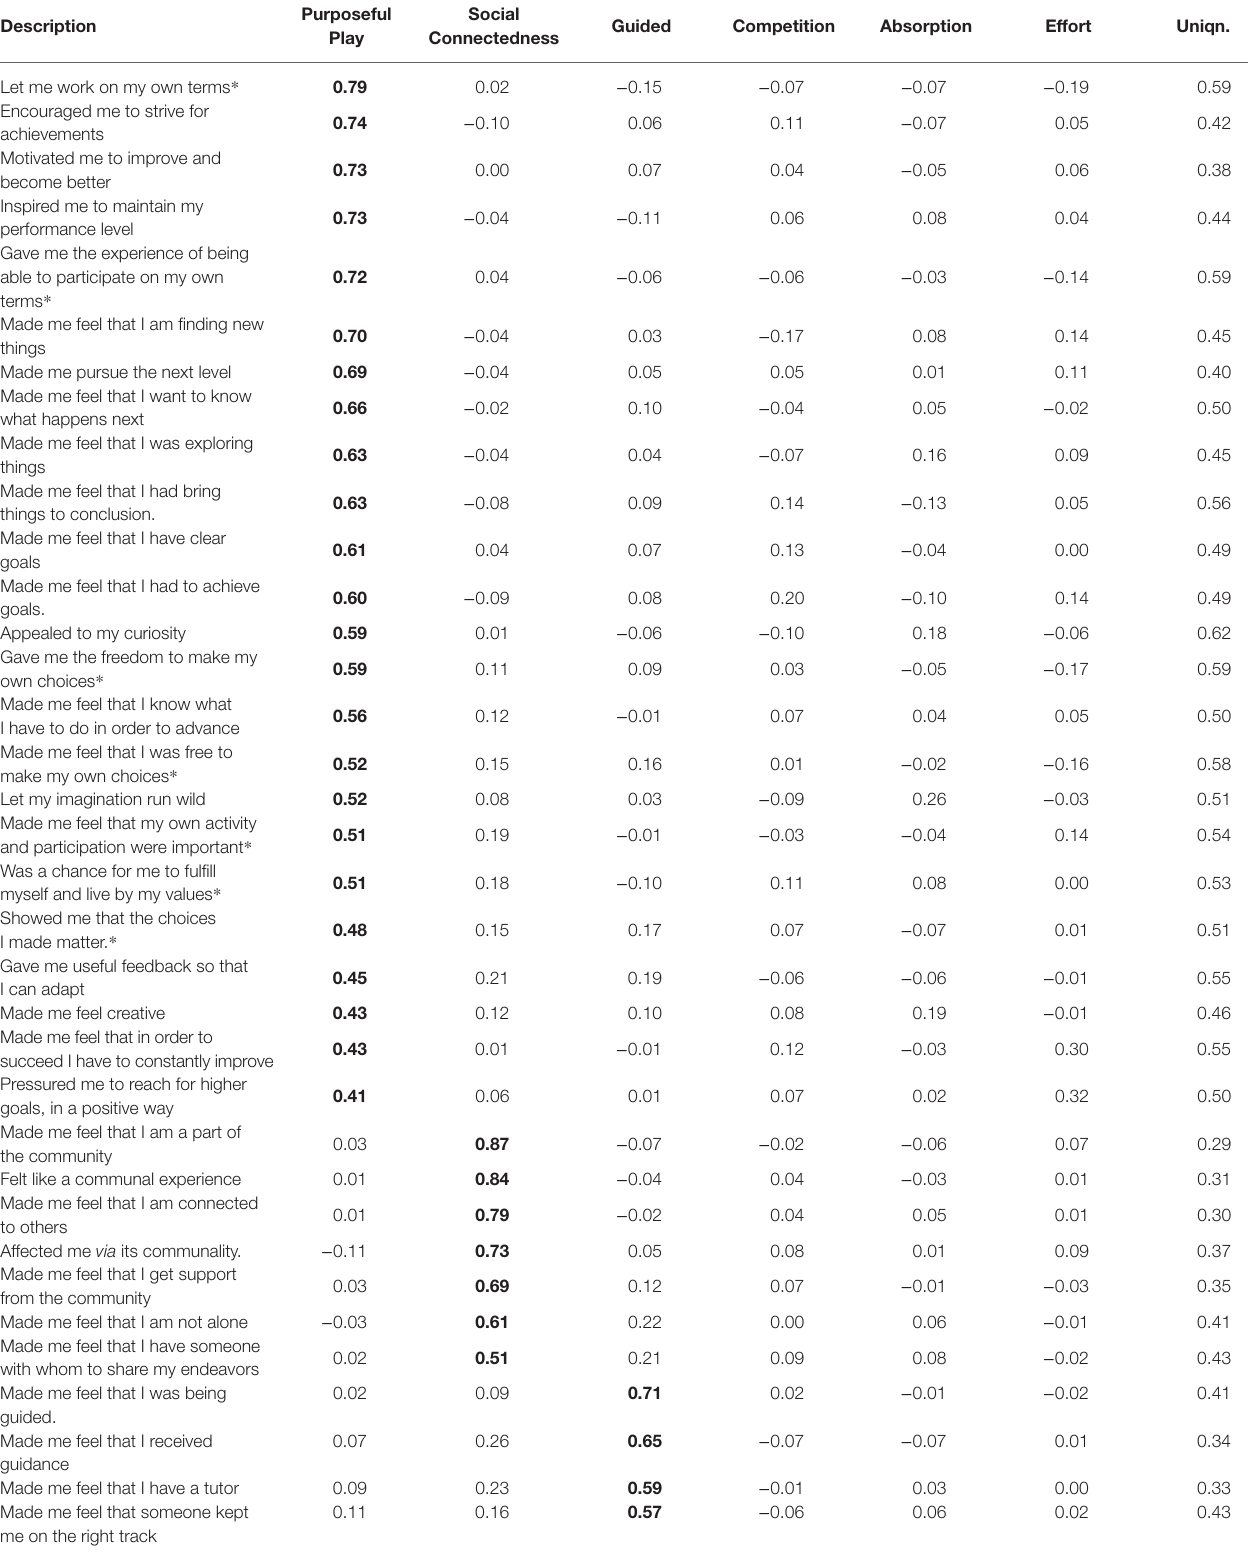
TABLE 3 | Factor loading table and uniqueness for GAMEFULQUEST, complemented by autonomy-based items (marked with “ * ” in the table). Description